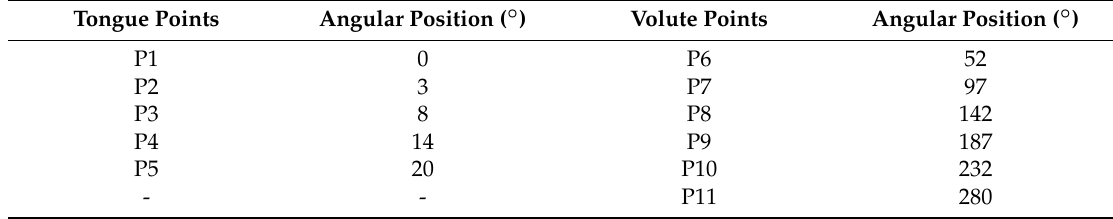
Figure 5. Installation of test system. ( a ) Test equipment; ( b ) The flow chart of test system installation. Table 2. Angular coordinate of the measurement points over the